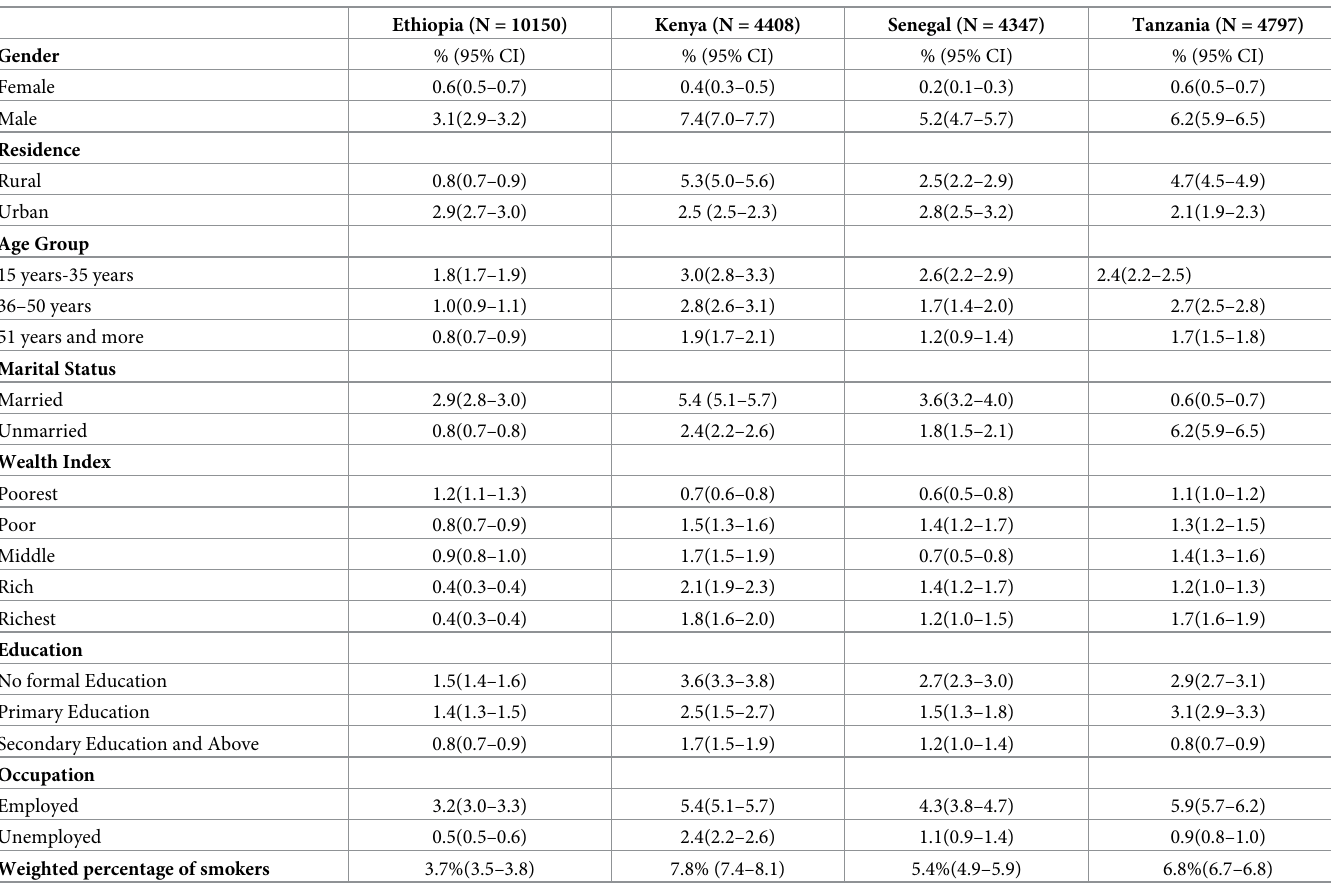
Table 1. Percentage of smokers across various socio-economic characteristics in the GATS sample.